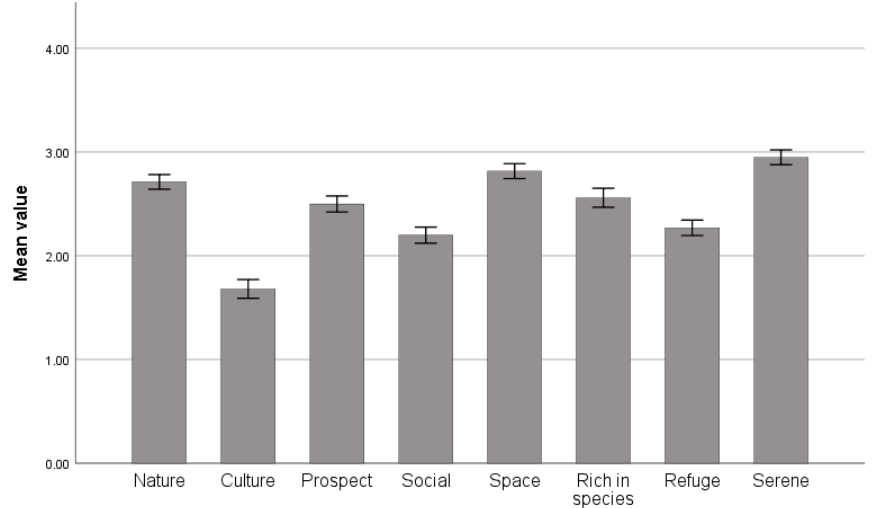
Figure 6. The mean value of each dimension of PSDs. Data are presented as the means ± SEs.